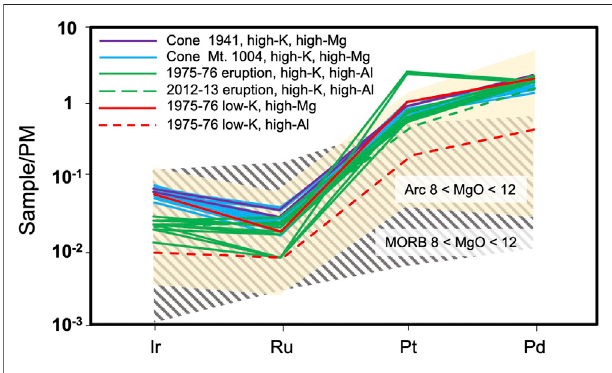
FIGURE 7 | Primitive mantle-normalized PGE patterns of the Tolbachik lavas compared to arc and MORB rocks. Only samples with MgO contents between 8 and 12 wt.% are displayed. Same references as Figure 8 . Values normalized following Lyubetskaya and Korenaga